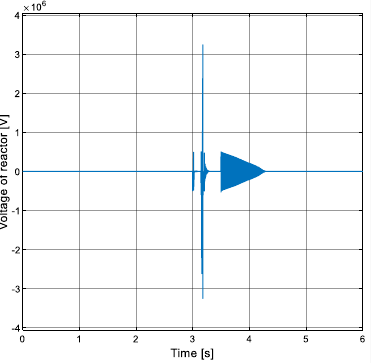
Figure 10. Voltage waveform on the reactor.